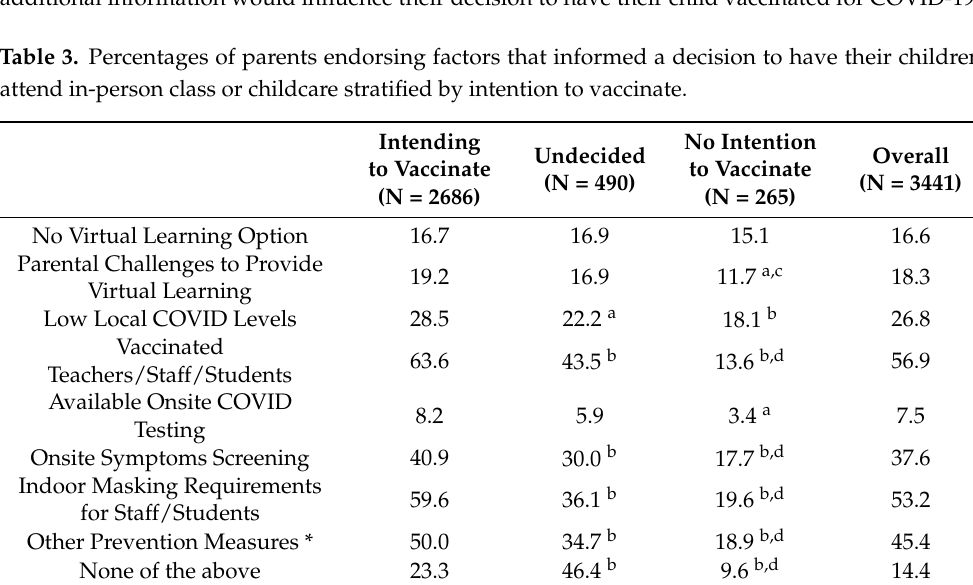
Table 3. Percentages of parents endorsing factors that informed a decision to have their children attend in ‐ person class or childcare stratified by intention to vaccinate.